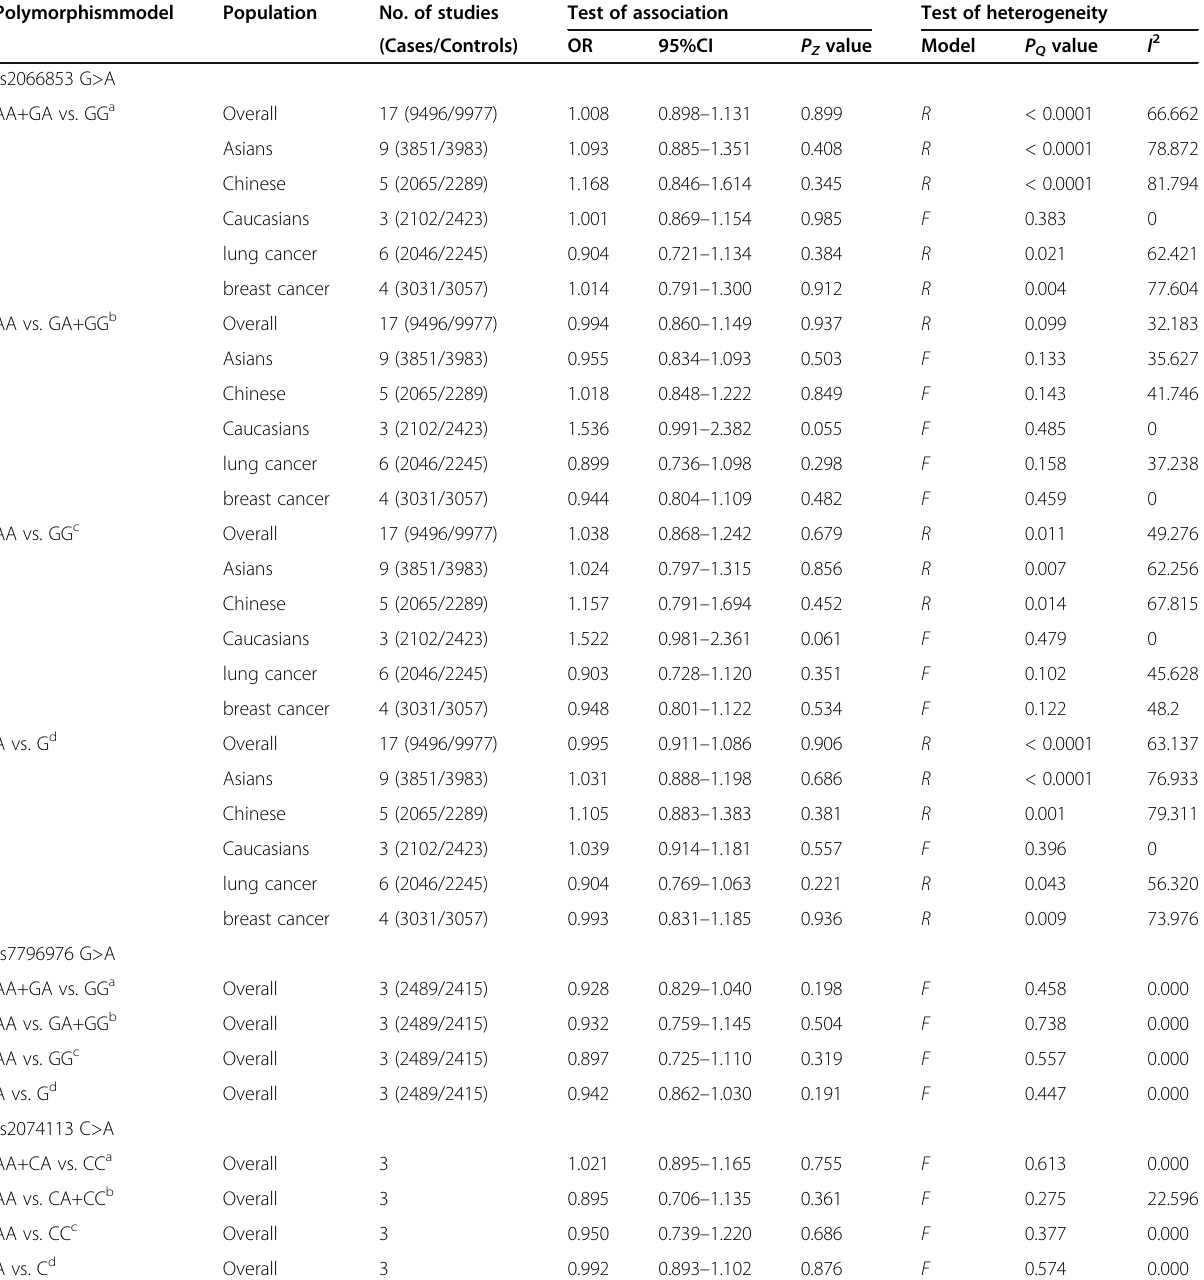
Table 3 Overall and subgroup meta-analysis of the association between AhR polymorphisms and cancer risk